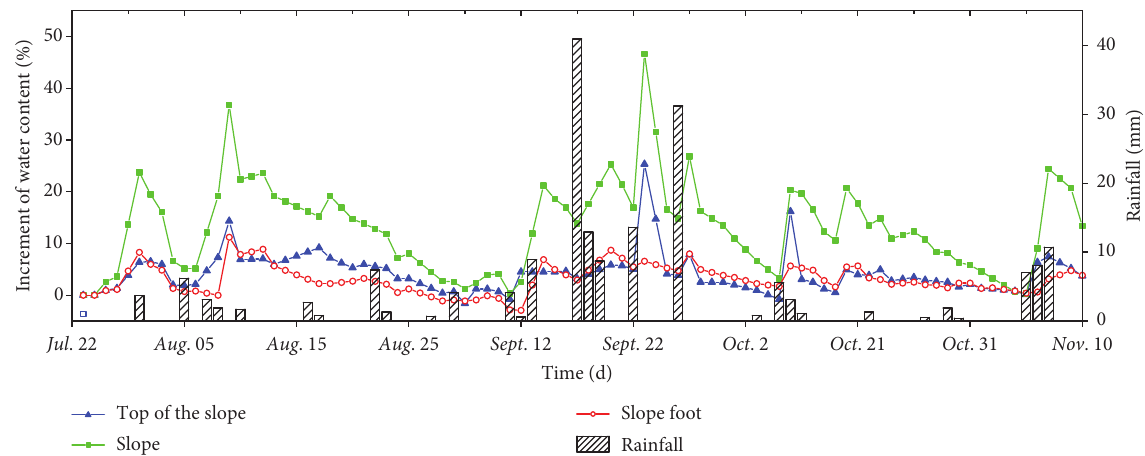
Figure 4: Time history curve of water content at different positions on the slope (buried depth 20cm).